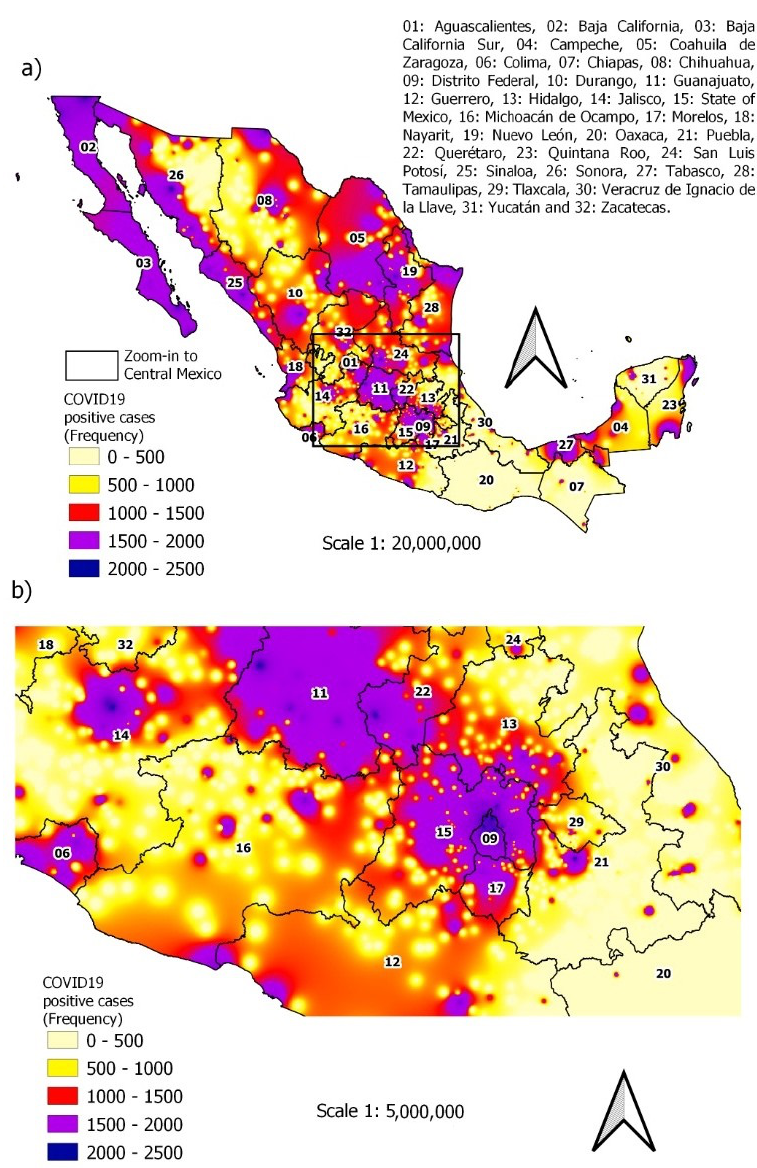
Figure 6. Spatial distribution of COVID-19 positive cases: ( a ) national context; ( b ) zoom-in to Central